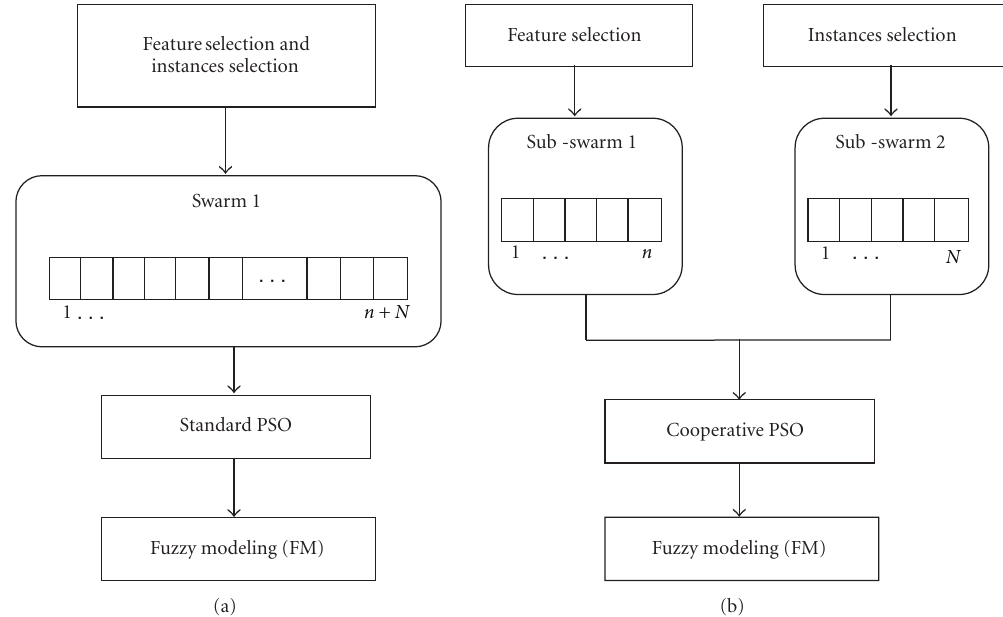
Figure 4: The particle scheme of the “standard” PSO (a) and cooperative PSO